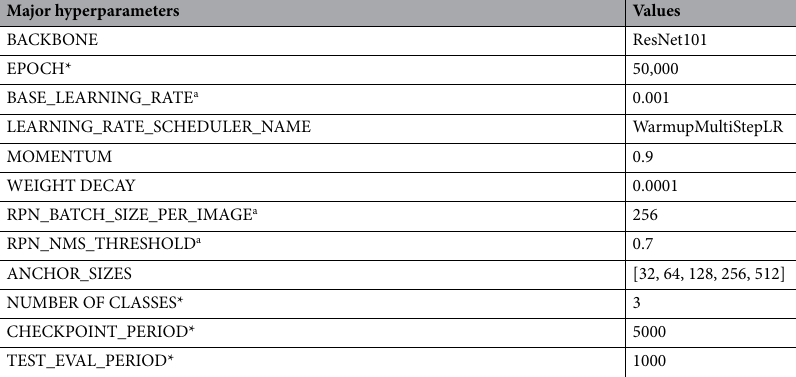
Table 3. Major hyperparameters and values used with Mask R-CNN training. Hyperparameters with * were used with custom values. Hyperparameters with a were tuned by testing a set of values before selecting the best value. The rest of the hyperparameters were used with the default values. The description of the hyperparameters can be found at https:// detec tron2. readt hedocs. io/ en/ latest/ modul es/ index.